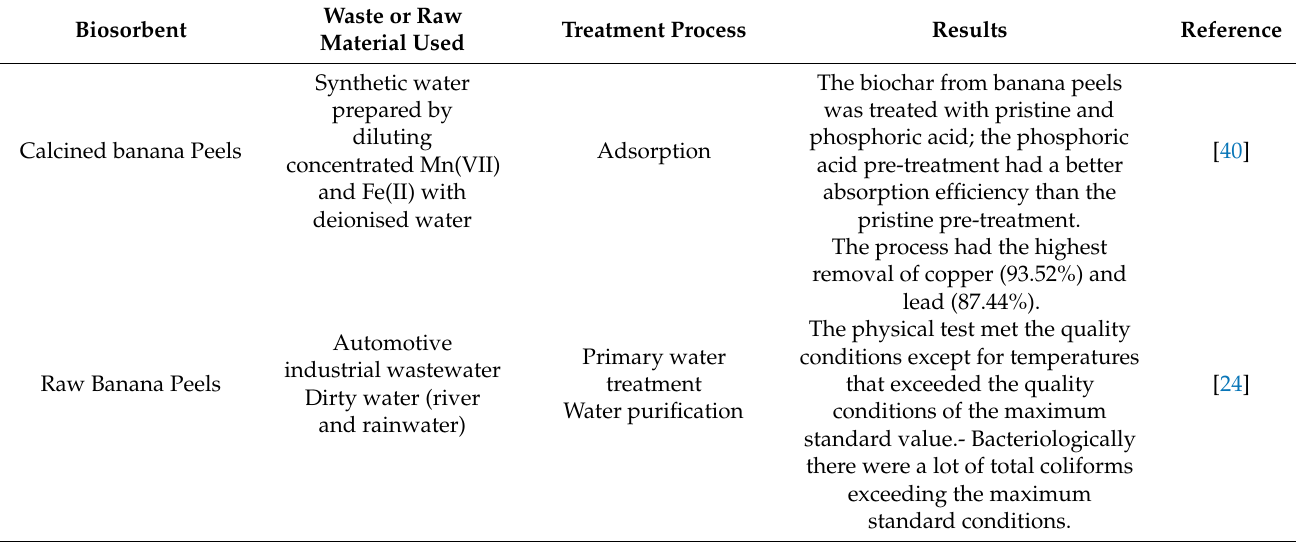
Table 1. Biomaterials and magnetite used for wastewater remediation and energy production as compared to current study.